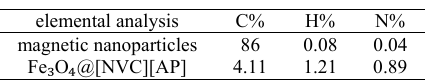
Table 1. Result of elemental analysis